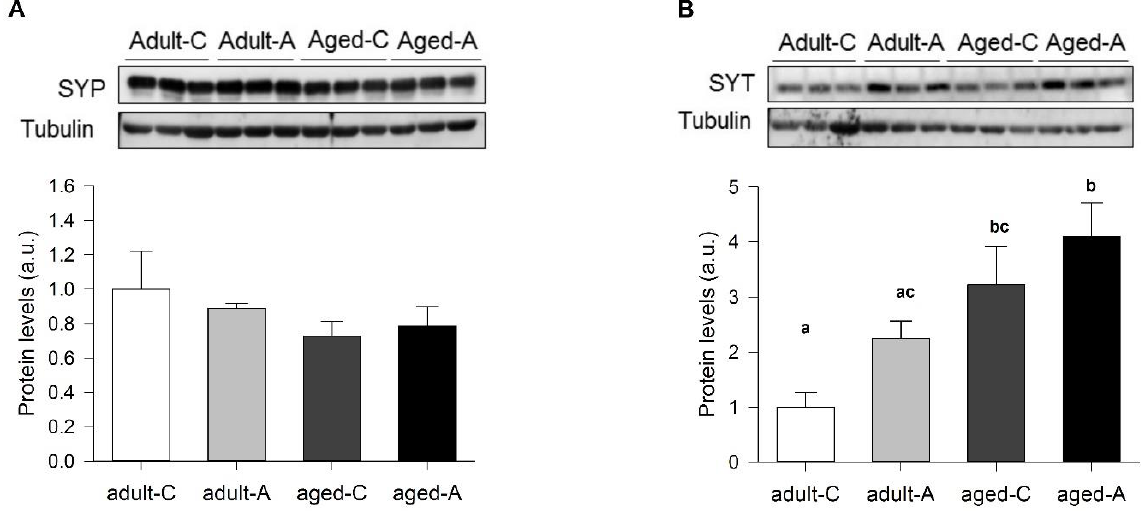
Figure 7. Differential effect of long-term ANDRO administration in the hippocampal presynaptic protein of adult and aged female degus. Densitometric analysis of presynaptic proteins: ( A ) SYP and ( B ) SYT of adult (36 months old) and aged (72 months old) control (C) and ANDRO (A) female degus. Data were analyzed statistically using one-way ANOVA, with the p -value indicated at the top of each figure. Different letters above bars show statistical differences between the same protein across the ANDRO treatments (Fisher’s LSD post hoc test). Results are expressed as mean ± SE (n = 3); a.u: arbitrary units.